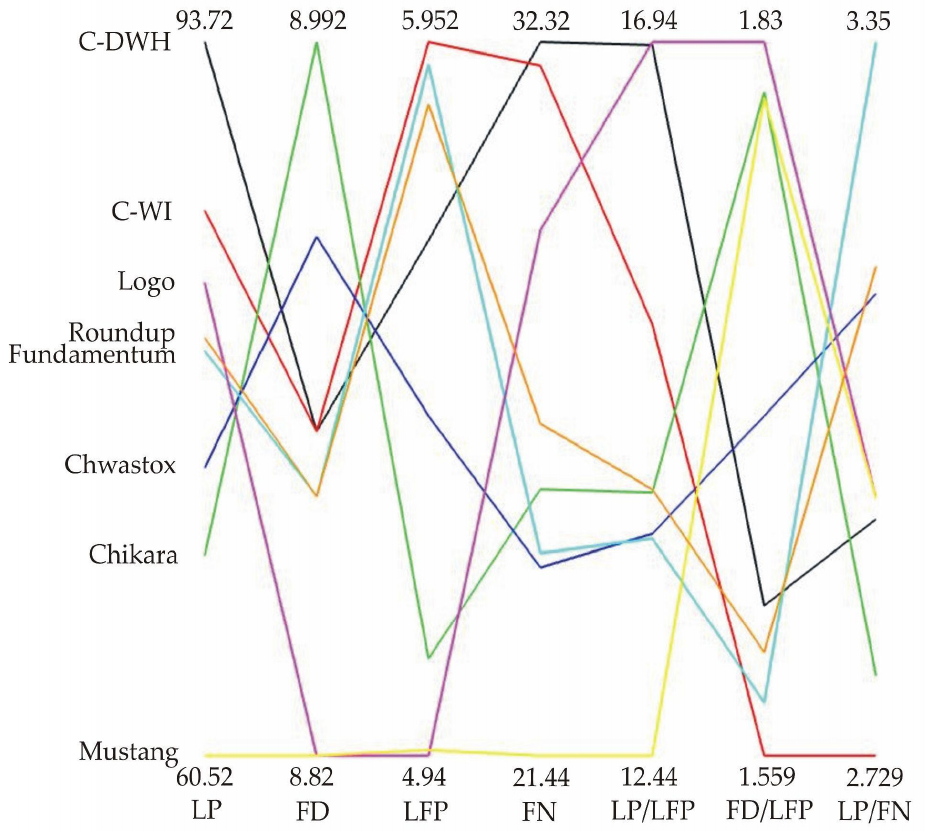
Figure 3. Parallel coordinate plots (PCPs) for nine herbicides and seven features. LP—length of peduncle, FD—flower diameter, LFP—length of flower peduncle, FN—flower number. The numbers for particular features mean minimal (down) and maximal (up) average values for herbicides.